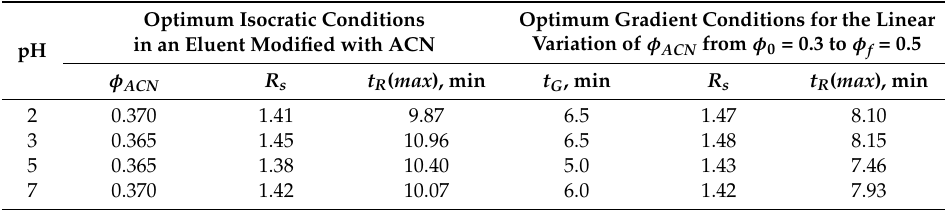
Table 1. Optimal conditions found for the separation of the mixture of solutes using an Excel